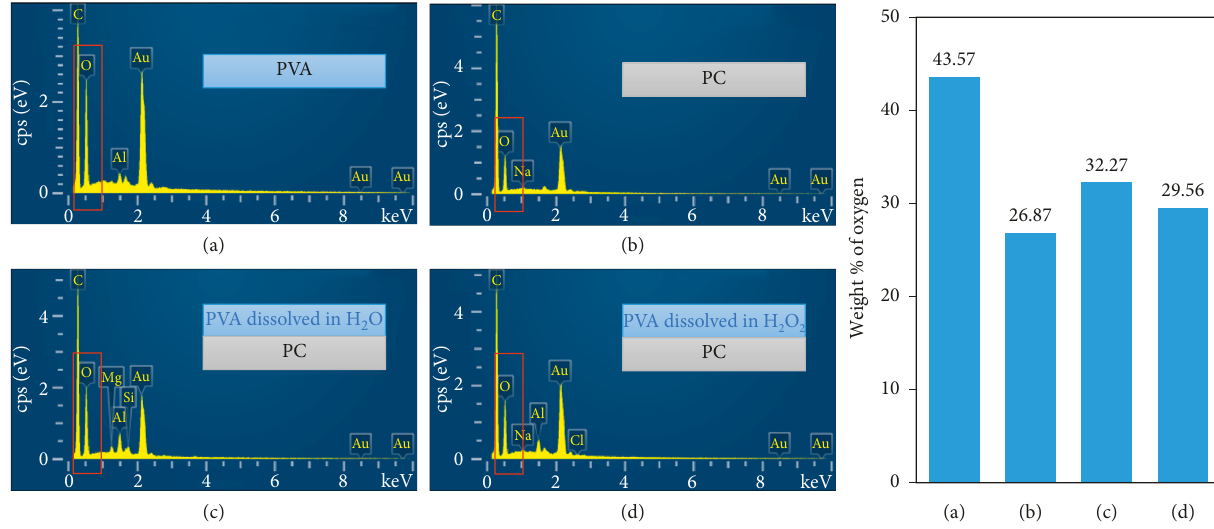
Figure 7: EDX spectra including comparative oxygen peaks on the surface of (a) PVA, (b) PC, and PC-PVA specimens after PVA dissolution in (c) H 2 O and (d) H 2 O 2 . The red boxes in (c) and (d) indicate oxygen peaks. The histogram on the right indicates the weight composition of oxygen in each specimen.